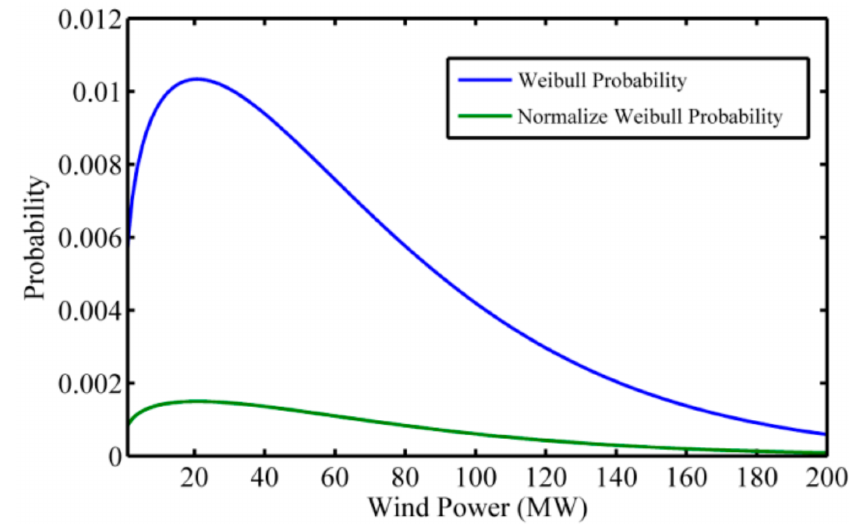
Figure 3. Density of Weibull